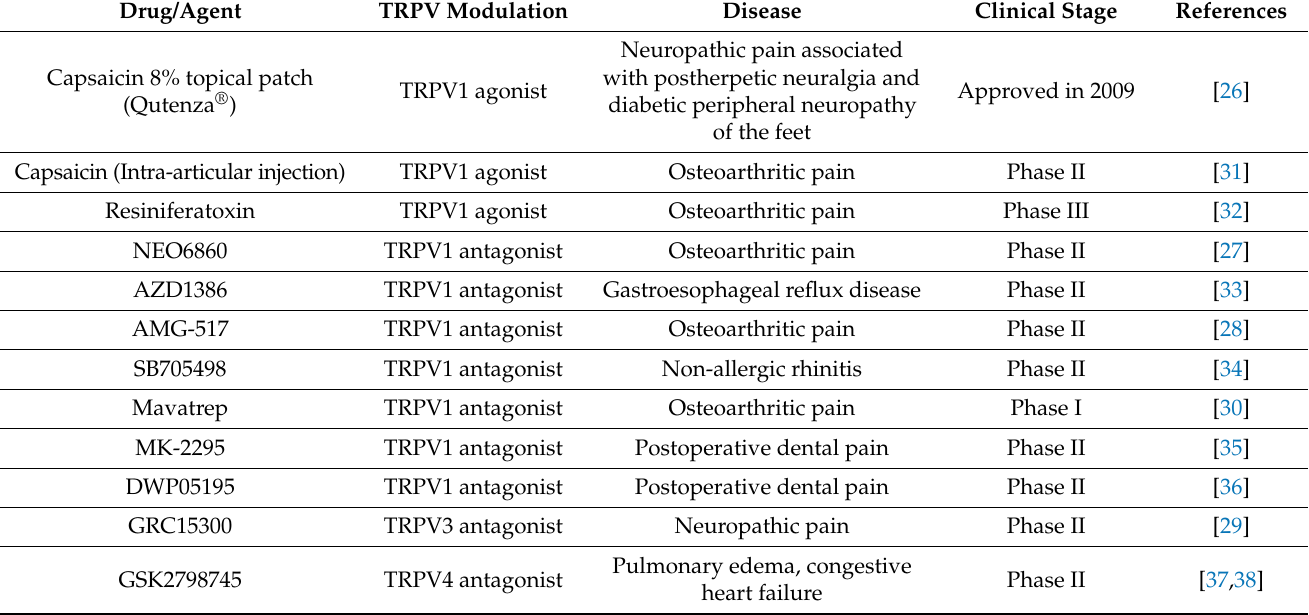
Table 1. Overview of clinical trials and approved drugs targeting transient receptor potential vanilloid (TRPV)1–4. Drug/Agent TRPV Modulation Disease Clinical